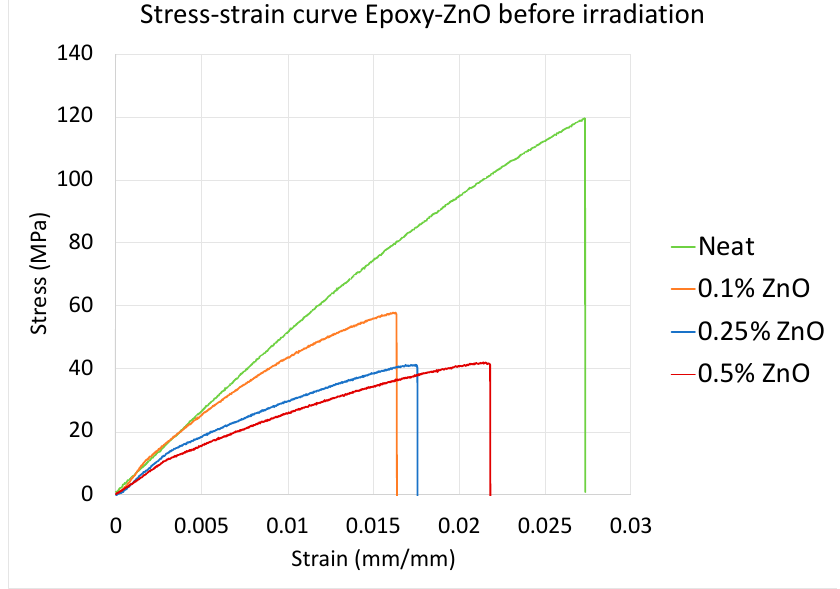
Table 5. Flexural properties of epoxy-ZnO composites after irradiation.